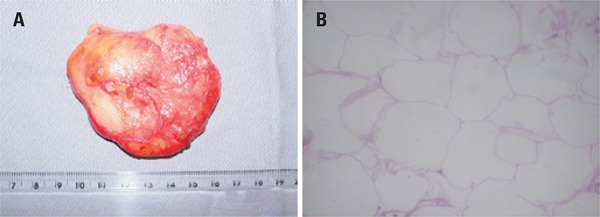
(A) Imagem do espécime cirúrgico. (B) Fotomicrografia do corte histológico do lipoma (hematoxilina e eosina, 200x)